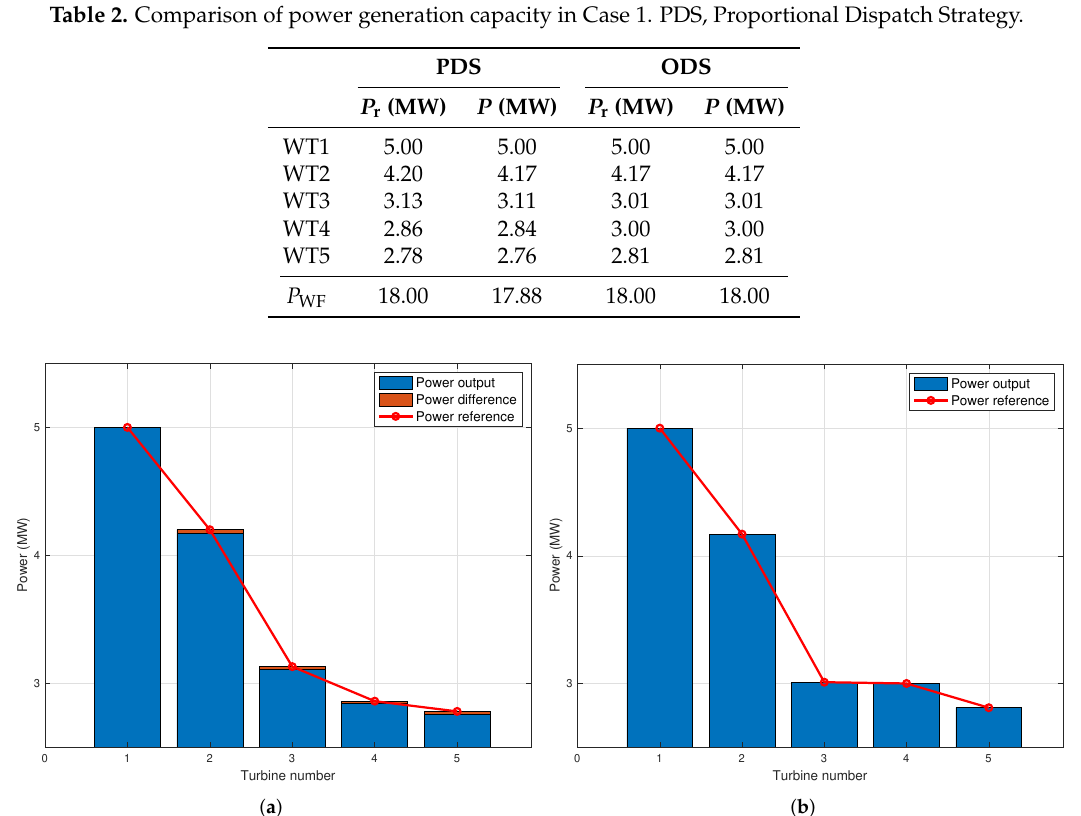
Table 2. Comparison of power generation capacity in Case 1. PDS, Proportional Dispatch Strategy.